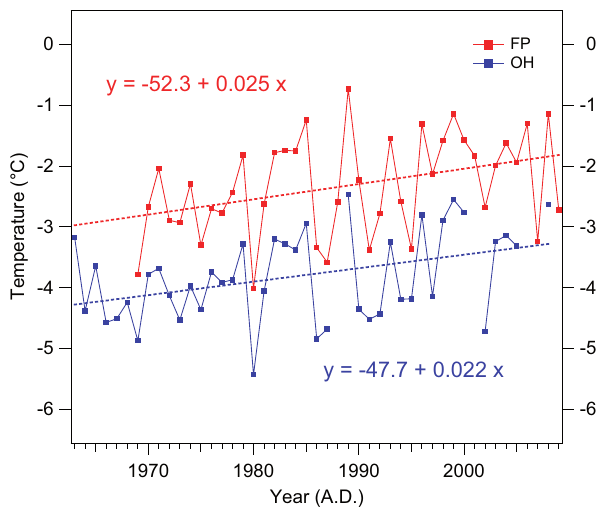
Fig. 2. Mean annual air temperature (MAAT) of the last 4 to 5 decades from Bellingshausen station (FP, red line), King George Island, and O’Higgins station (OH, blue line), Antarctic Peninsula. For both stations linear regression (dotted lines) are presented, as well as the annual air temperature trend (equations).